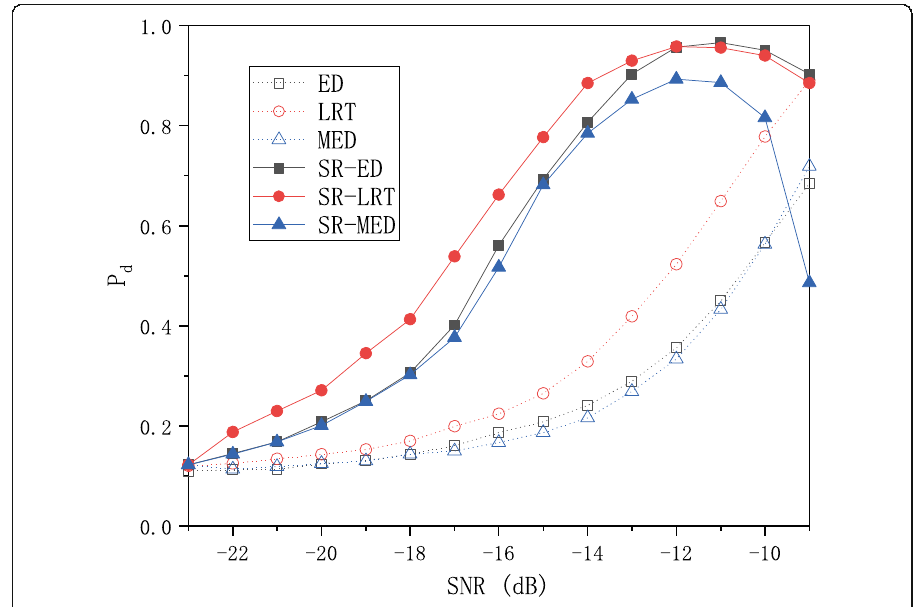
Fig. 8 The comparison of detection probability under Rayleigh channel without filters